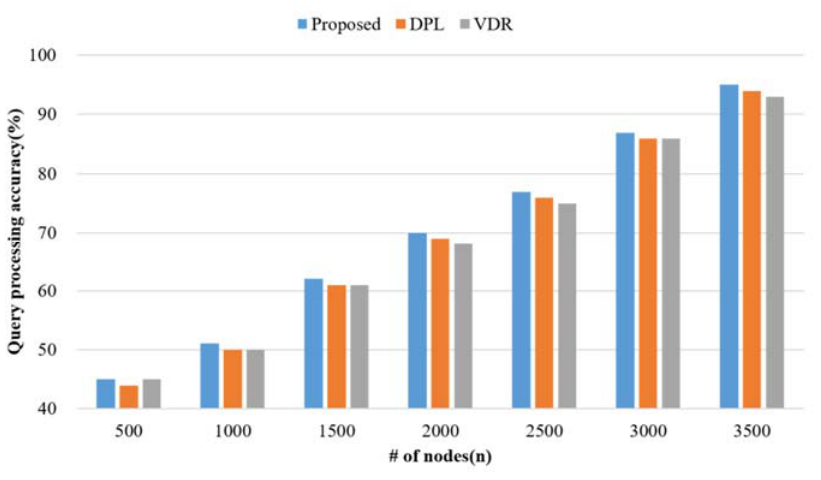
Figure 11. Query-processing accuracy according to the number of Figure 11. Query ‐ processing accuracy according to the number of nodes.